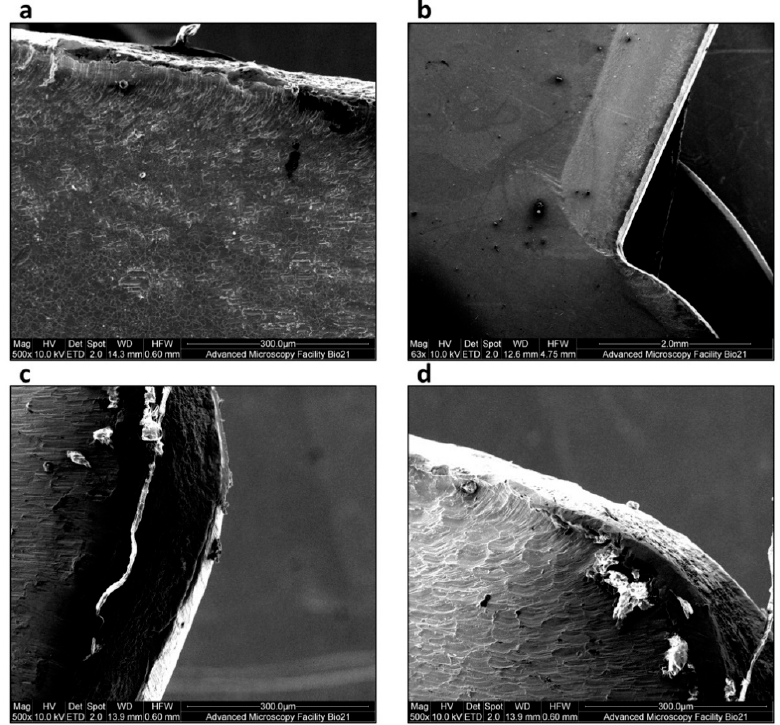
Figure 5. Scanning electron microscope (SEM) observation of blades in Rigeneracons ® . A blade after 2 min of processing shows evidence of ( a ) significant wear as damage on the front cutting portion of the blades with visible peeling of the edges. Debris, forming into aggregates of up to 400 μ m, was also found on the blades’ surface ( b – d ).